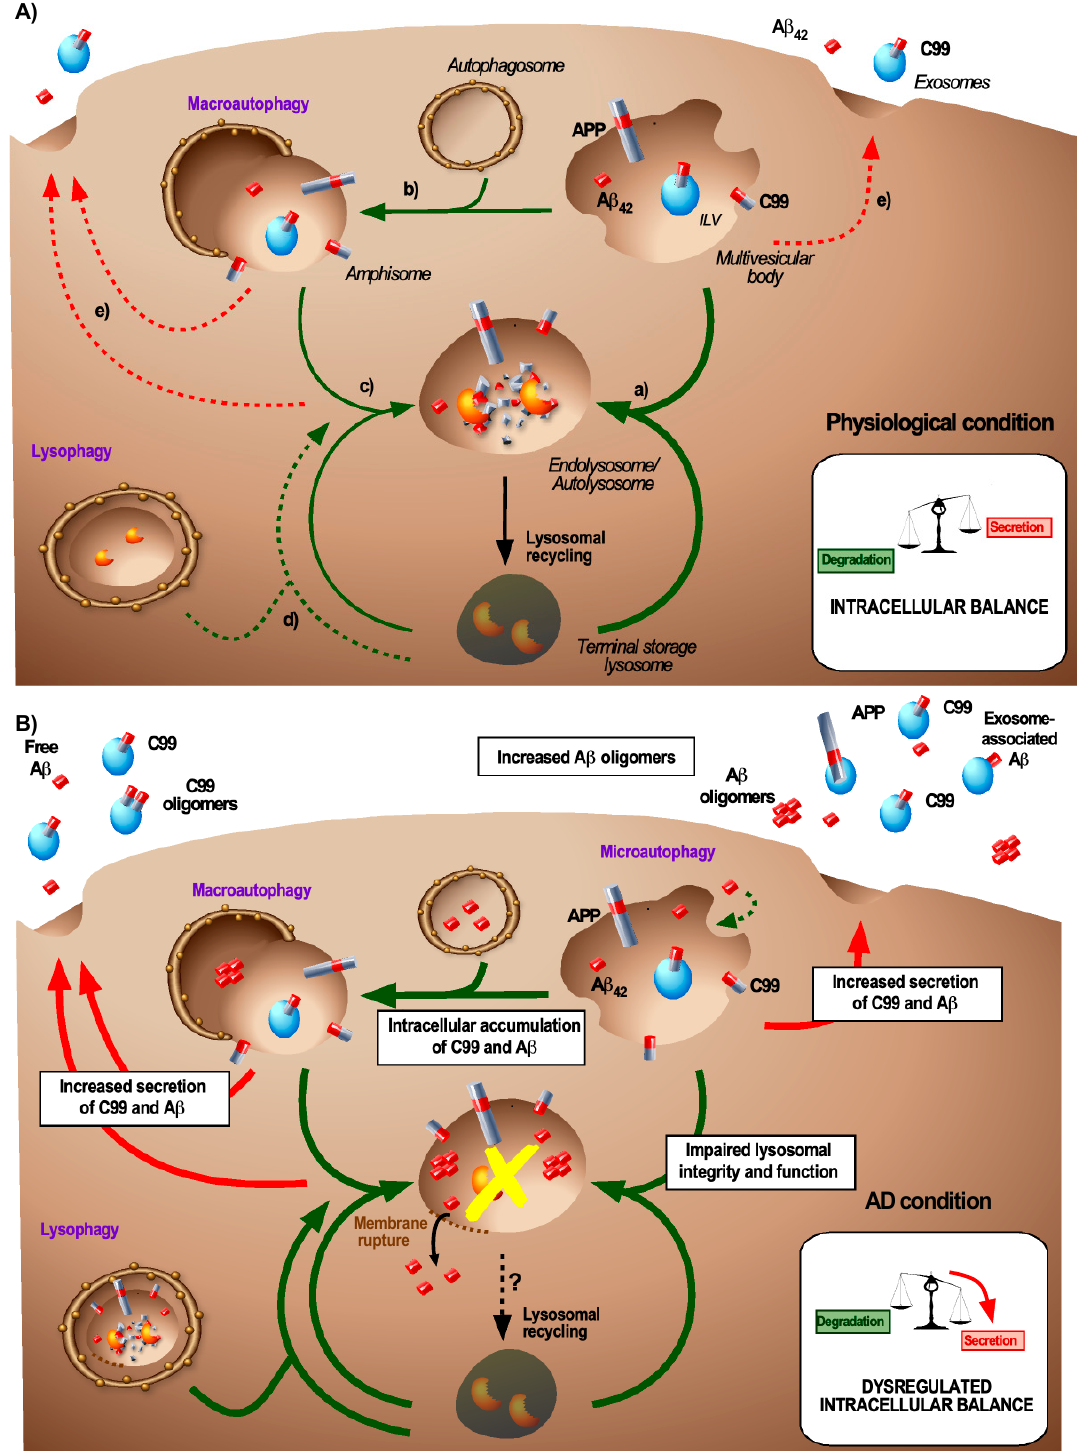
Figure 2. Balance between APP product degradation and secretion under normal and AD-associated conditions. ( A ) Intracellular balance for the generation and degradation of APP products under physiological conditions. Under physiological conditions, MVBs that may contain APP/C99/A β 42 can have several fates, all leading to the degradation of their content by lysosomal enzymes: ( a ) MVBs fuse directly with terminal storage lysosomes to form degradative endolysosomes or ( b ) they reach the autophagic pathway by a subsequent fusion with autophagosomes that forms amphisomes and ( c ) terminal storage lysosome (TSL) to generate autolysosomes. Under physiological conditions, the selective clearance of excessive lysosomes through lysophagy ( d ) or the release of the MVB-,